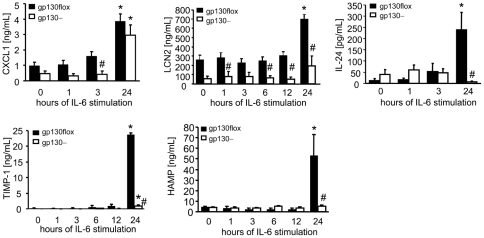
Analysis of gp-130 regulated soluble factors.CXLC1, LCN2, TIMP-1, HAMP and IL-24 concentration in the supernatant of IL-6 stimulated hepatocytes. Stimulation with IL-6 for 24 hours induces the release of CXCL1, LCN2, TIMP-1, HAMP and IL-24 within the supernatant of WT (gp130 flox)-derived hepatocytes (CXCL1, LCN2, TIMP-1, HAMP and IL-24) or gp130–-derived hepatocytes (CXCL1, TIMP-1). CXCL1 was found to be differentially regulated after 3 hours of IL-6 stimulation, LCN2 1, 6, 12 and 24 hours after IL-6 stimulation TIMP-1 and HAMP after 24 hours after IL-6 stimulation. Data are presented as mean±SEM of at least 4–5 independent experiments.